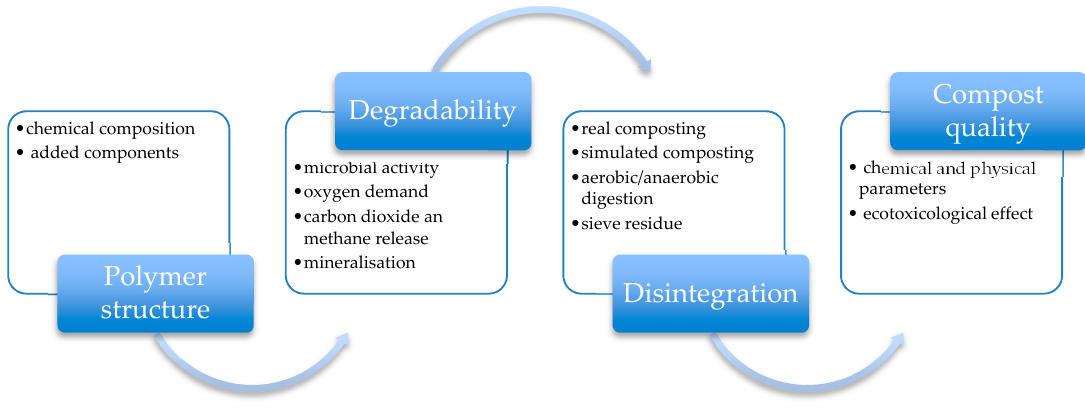
Figure 6. Degradation pathways of biodegradable